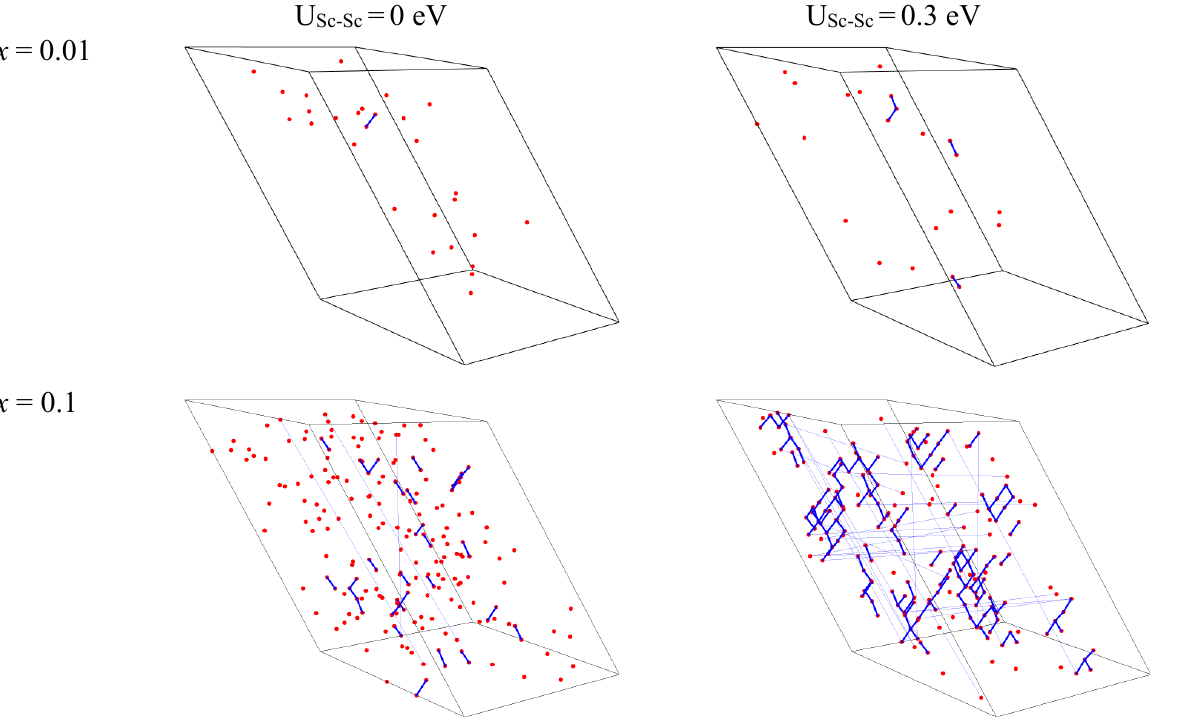
Figure 8. Examples of Sc ion location in the supercell without (left column) and with (right column) account of the correlations in ions location for two concentrations of Sc ( x = 0.01 and 0.1). Sc ions are shown by red points while blue lines are connecting adjacent Sc ions. Thin blue lines are connecting adjacent Sc ions with account of supercell periodicity (Sc ions located at opposite sides of the supercell).